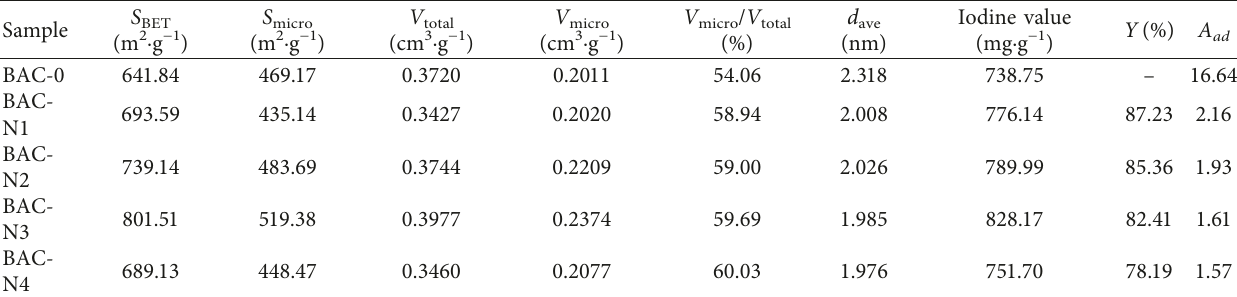
Table 3: Pore structure parameters, iodine value yield, and ash content of BACs.